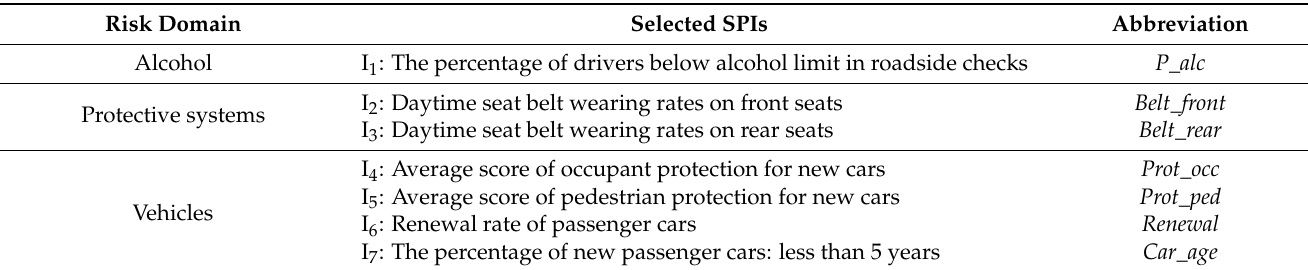
Table 2. Selected safety performance indicators for index